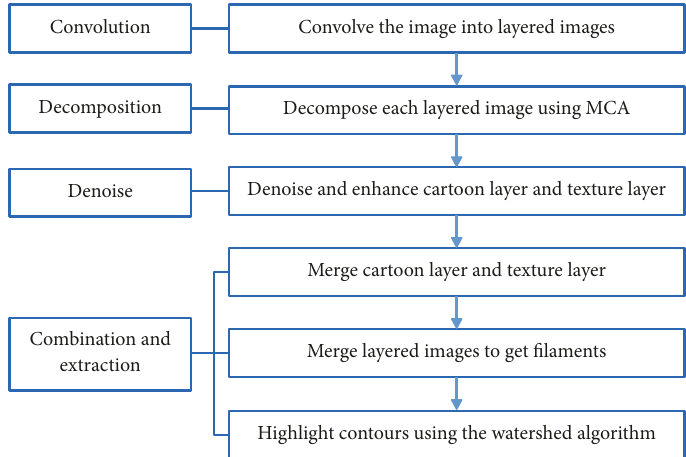
Figure 1: Flow of the filament extraction